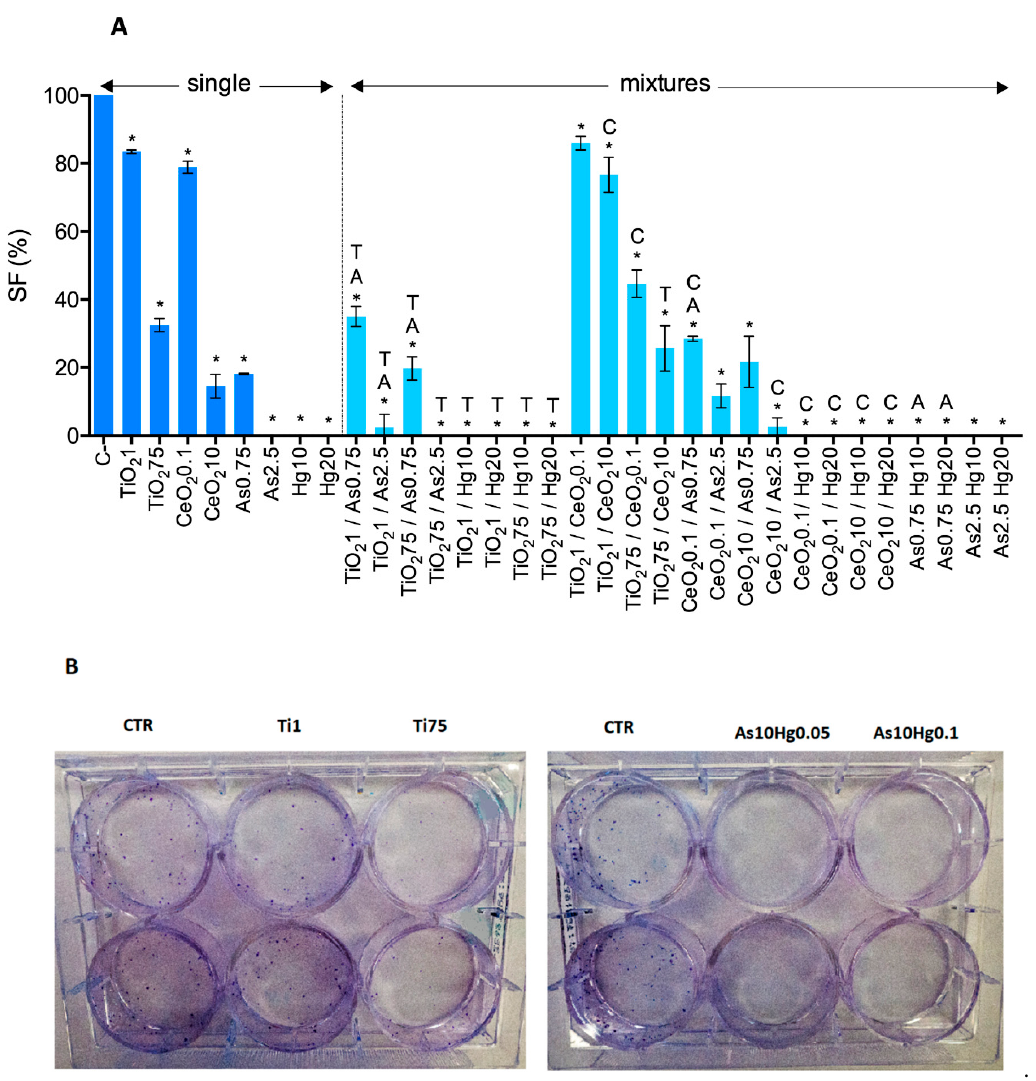
Figure 10. Clonogenic assay: ( A ) cytotoxicity of A549 cells exposed to TiO 2 NP, CeO 2 NP, As, and Hg alone or as binary mixtures for 7 days, determined by the clonogenic assay. Values are expressed as mean ± standard deviation (n = 3, each experiment in duplicate). All concentrations expressed in mg/L with the exception of CeO 2 NP which is expressed in μ g/L. Statistical significance of samples compared to C − is indicated by *; also indicated is statistical difference compared to Titanium T; Cerium C; Arsenic A; and Mercury H (one ‐ way ANOVA; p ≤ 0.05). ( B ) Representative images of Clonogenic assay after staining of the colonies.